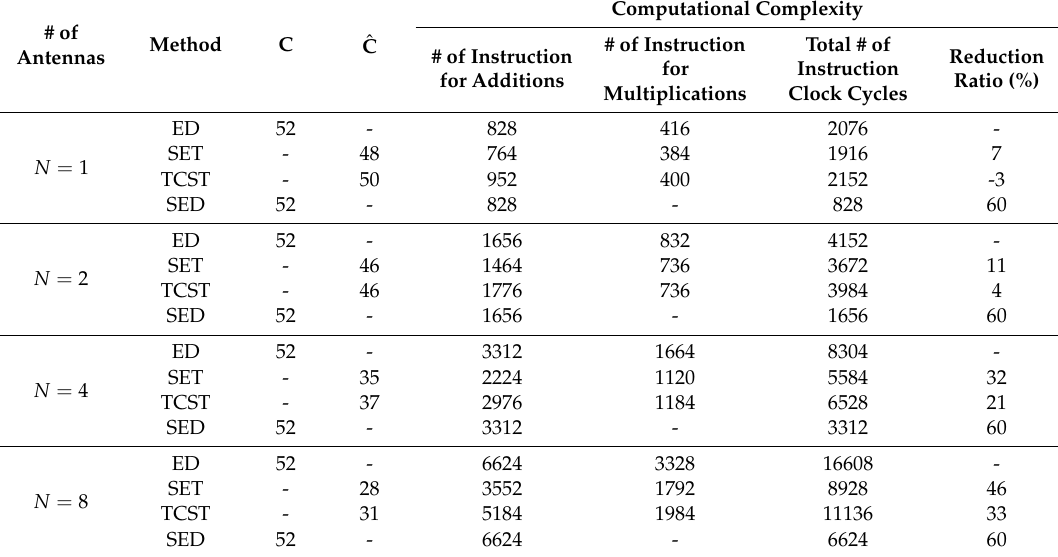
Table 4. Number of instruction cycles for proposed demodulation methods